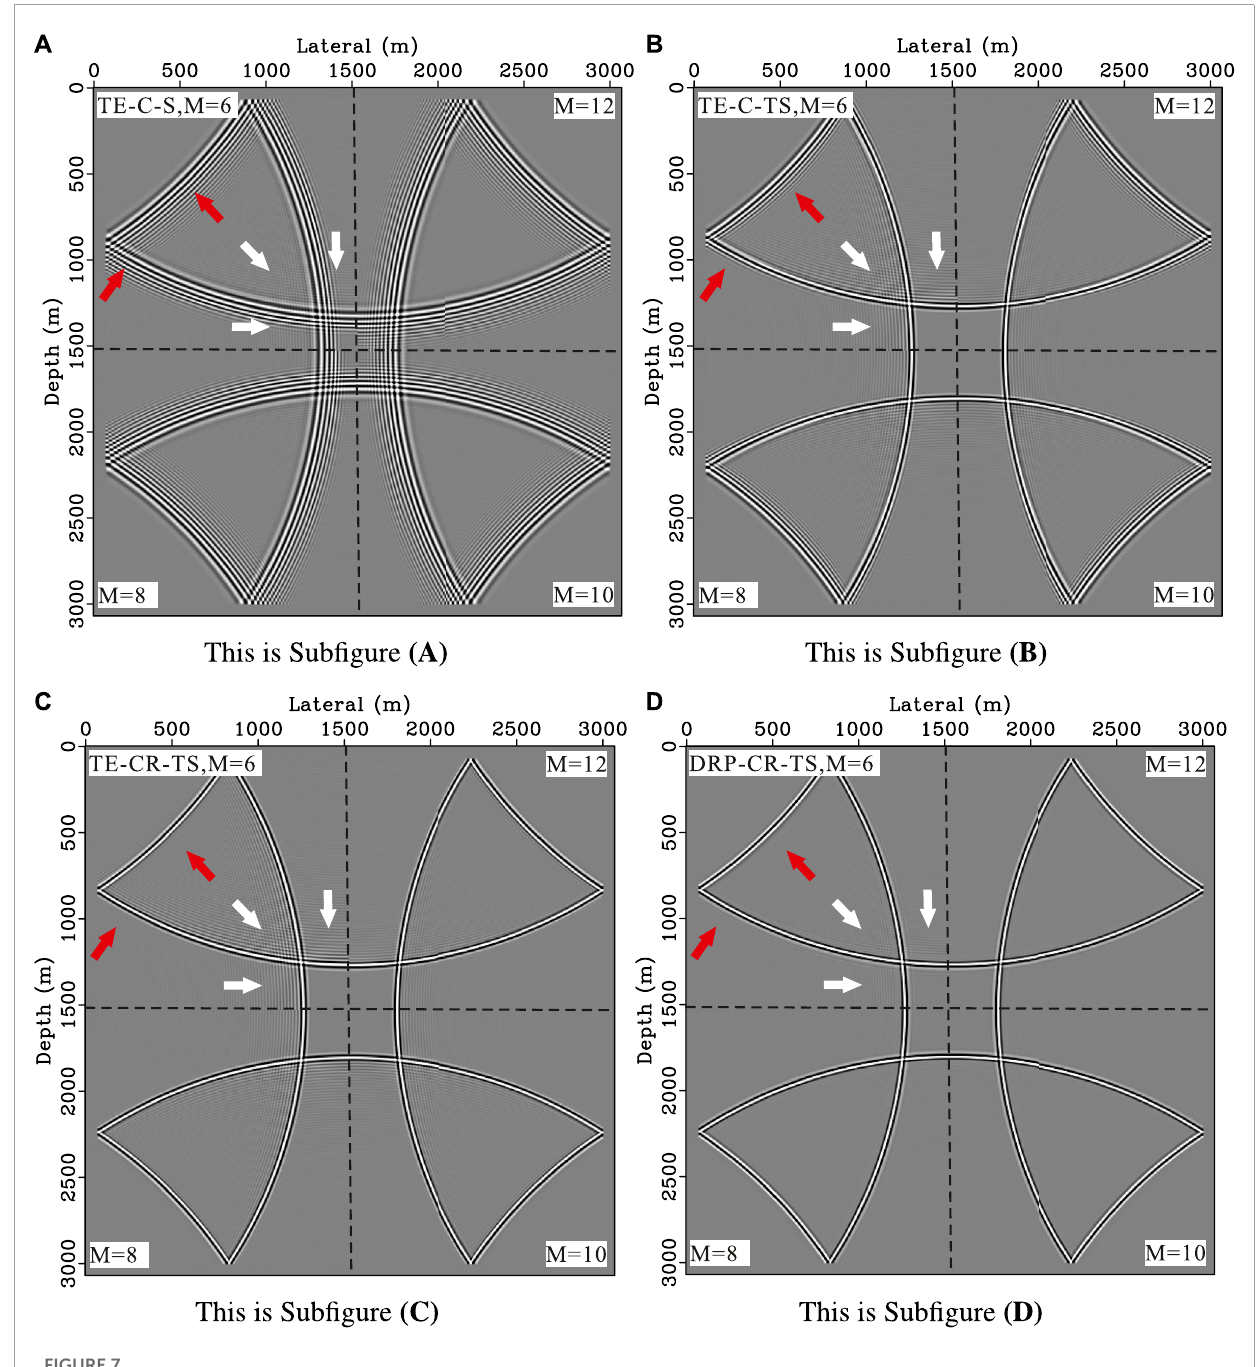
FIGURE 7 Snapshots of the four methods for different M , where τ = 0.0015 s , υ = 1500 m / s , h = 6 m , and N = 3 , L = M . The main frequency of the Ricker wavelet is 40 Hz . The four quadrants represent the snapshots of the same FD method for different M = 6,8,10,12 , respectively. (A) TE-C-S method. (B) TE-C-TS method. (C) TE-CR-TS method. (D) DRP-CR-TS method.